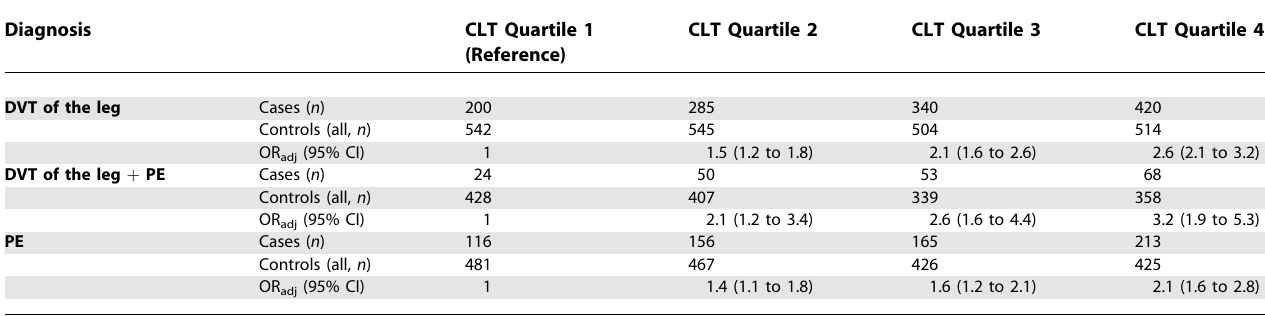
Table 2. Relative Risk of Venous Thrombosis According to Quartiles of Clot Lysis Time in Subgroups of Venous Thrombosis Diagnosis